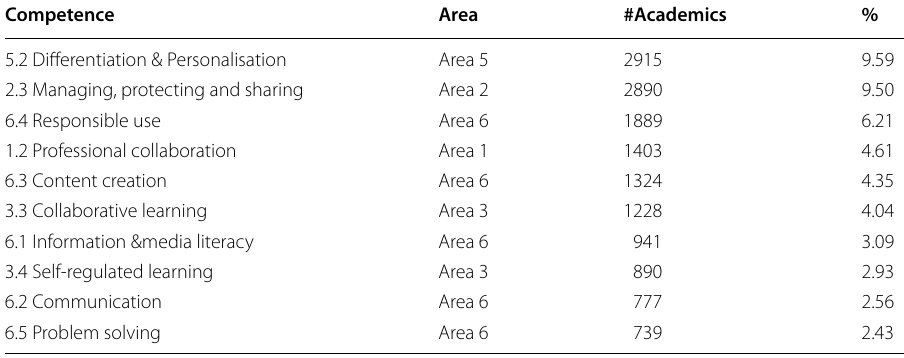
Table 9 The ten digital competencies with the highest number of academics who scored 0 Competence Area